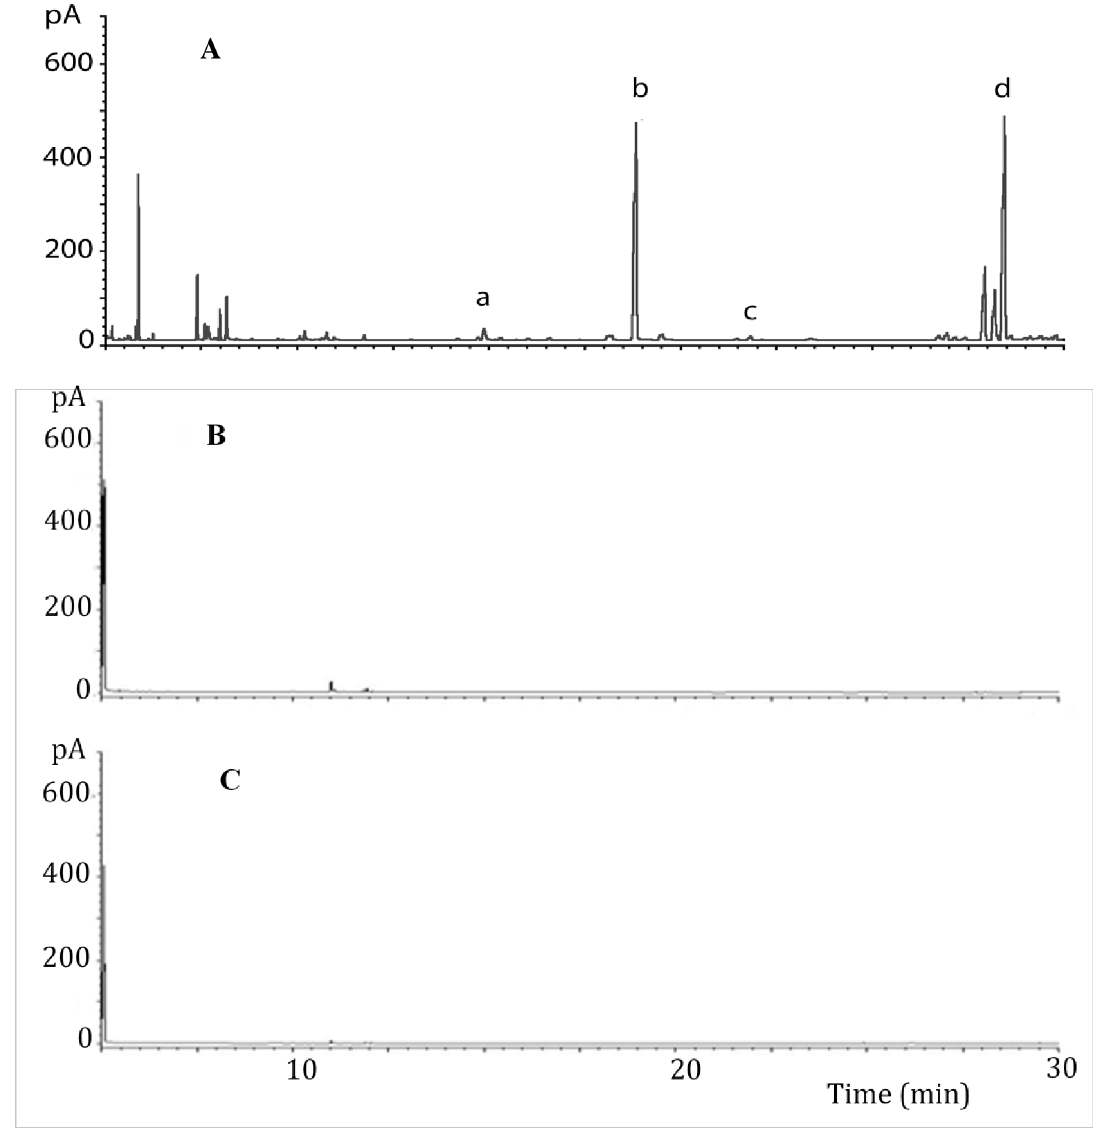
Fig 5. GC profiles of headspace volatiles from hybrid maize, HB515: ( A ) landrace ‘ Nyamula ’ exposed to oviposition used for induction, ( B ) HB515 exposed to egg-induced maize volatiles from neighbouring ‘ Nyamula ’ plant, ( C ) unexposed HB515 control plant. The identities of some of the EAG-activec ompounds whose emission was highly elevated by oviposition are as follows: (a) limonene; (b) ( E )-4,8-dimethyl-1,3,7, nonatriene (DMNT); (c) methyl salicylate; (d) decanal.